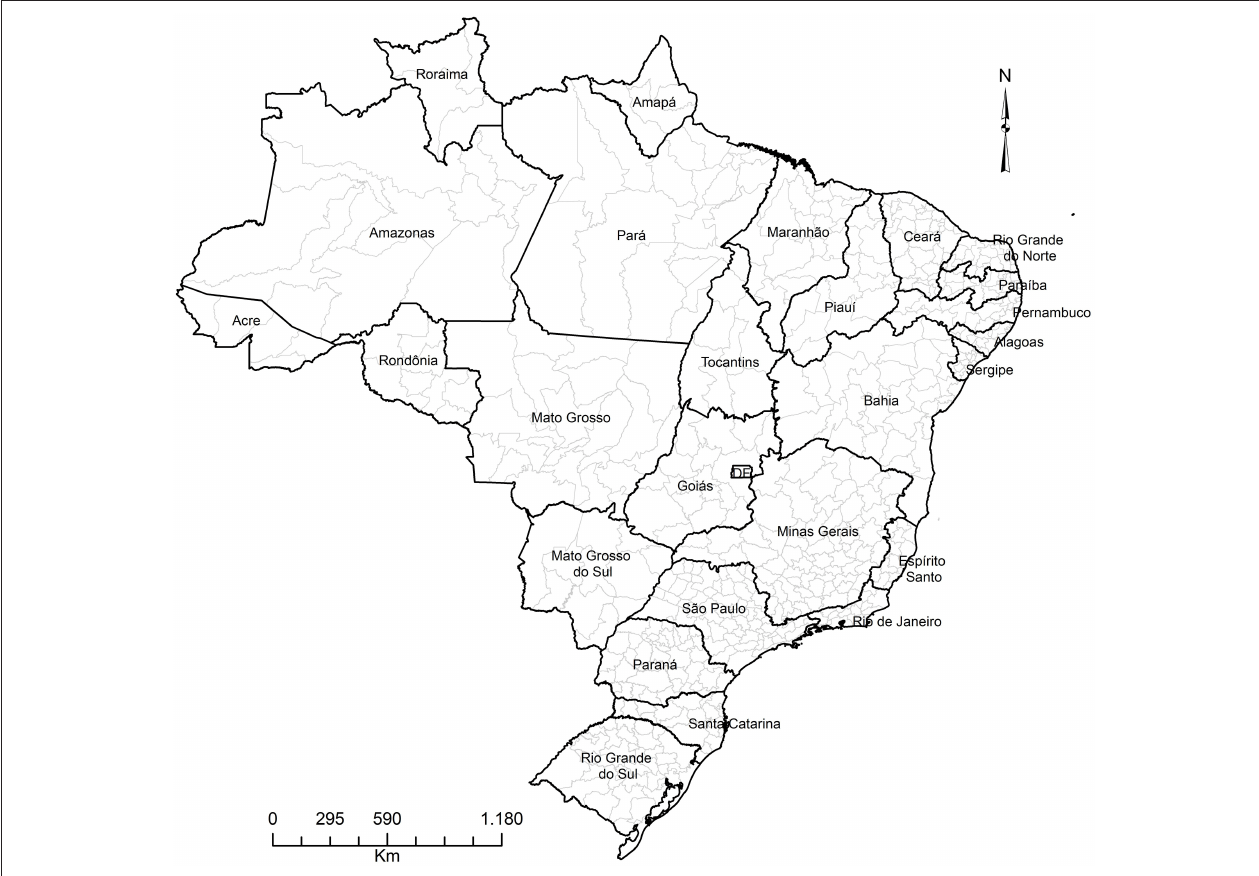
FIGURE 1 | Brazil by states and